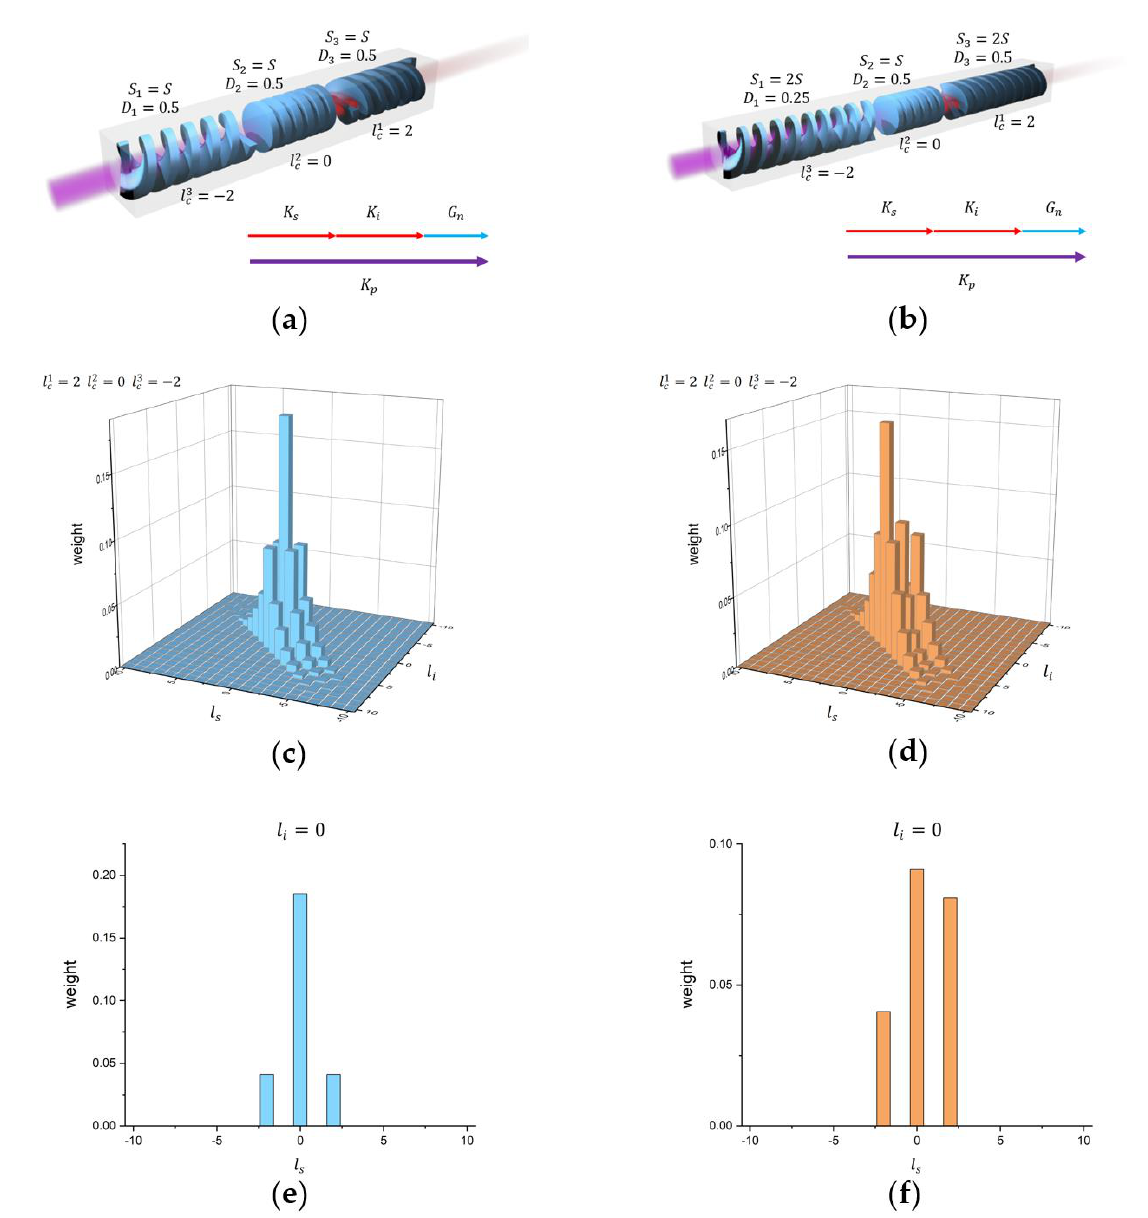
Figure 5. ( a ) The 3D spiral NPC consists of three segments of equal lengths S carrying topological charges of 𝑙 𝑐1 = 2, 𝑙 𝑐2 = 0, 𝑙 𝑐3 = −2 , respectively. The duty cycles are 0.5. ( b ) The cascaded spiral NPC with 𝑙 𝑐1 = −2, 𝑆 1 = 2𝑆, 𝐷 1 = 0.25, 𝑙 𝑐2 = 0, 𝑆 2 = 𝑆, 𝐷 2 = 0.5, 𝑙 𝑐3 = 2, 𝑆 3 = 2𝑆, 𝐷 3 = 0.5 . ( c , d ) are the normalized spiral spectra corresponding to ( a , b ), respectively. ( e , f ) are the spiral spectra of the signal lights corresponding to ( c , d ), respectively. Here, the idler light is projected onto the |0⟩ mode.